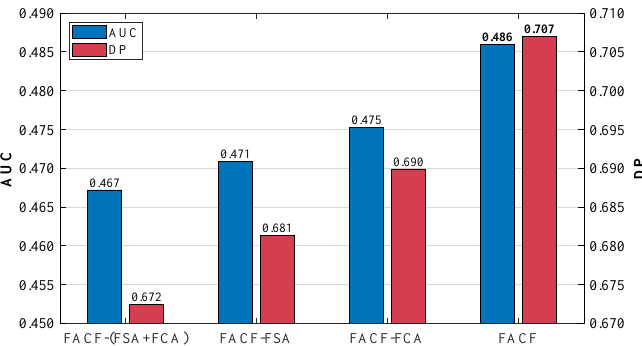
Figure 10. Ablation analysis of the proposed FACF tracker on three